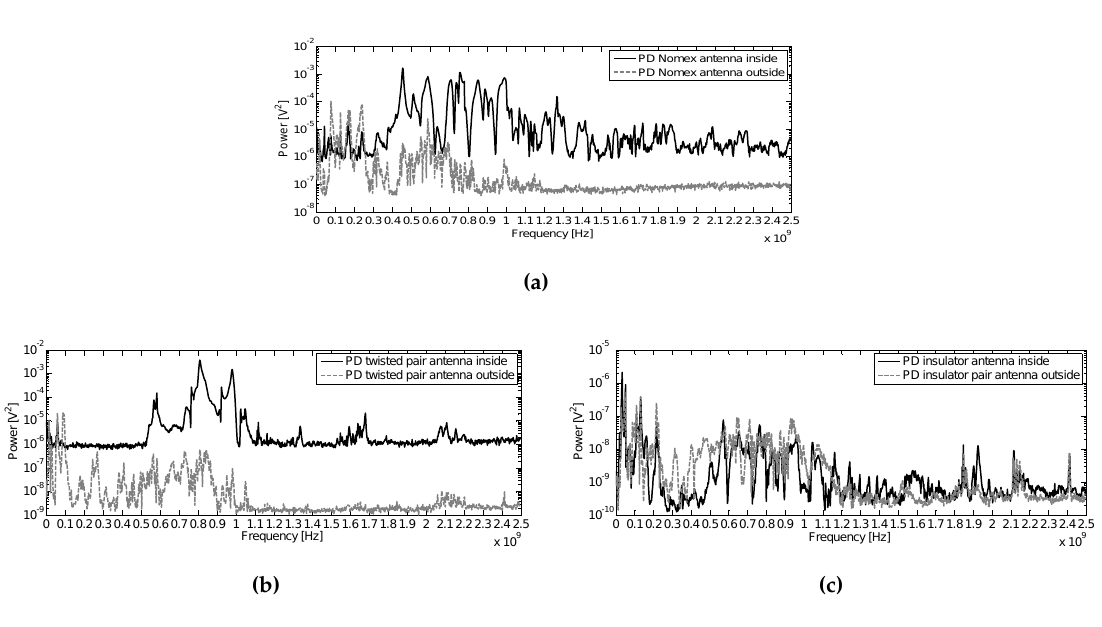
Figure 13. Average power spectra for PD measured from inside and outside the tank in ( a ) Nomex, ( b ) twisted pair and ( c ) insulator.